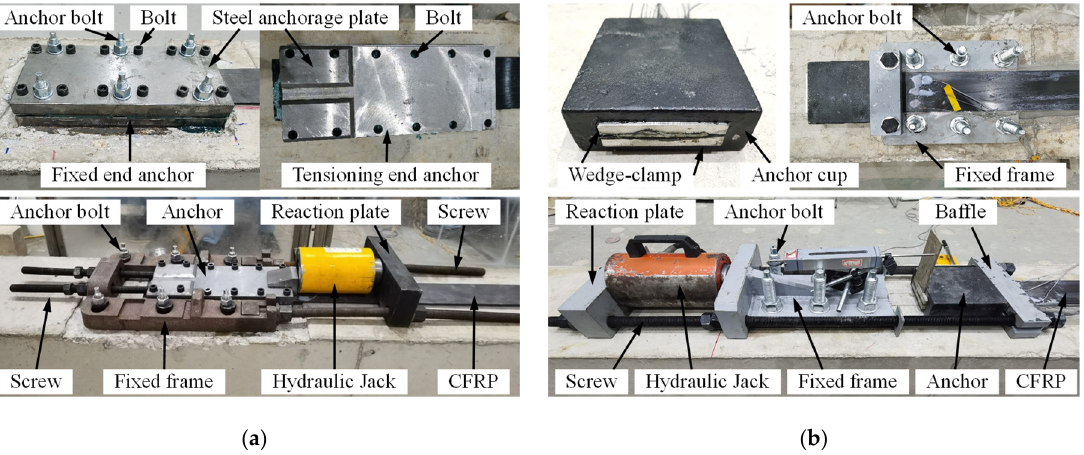
Figure 3. Prestressing systems used in the tests: ( a ) adhesive-friction anchor and ( b ) wedge-clamp anchor.